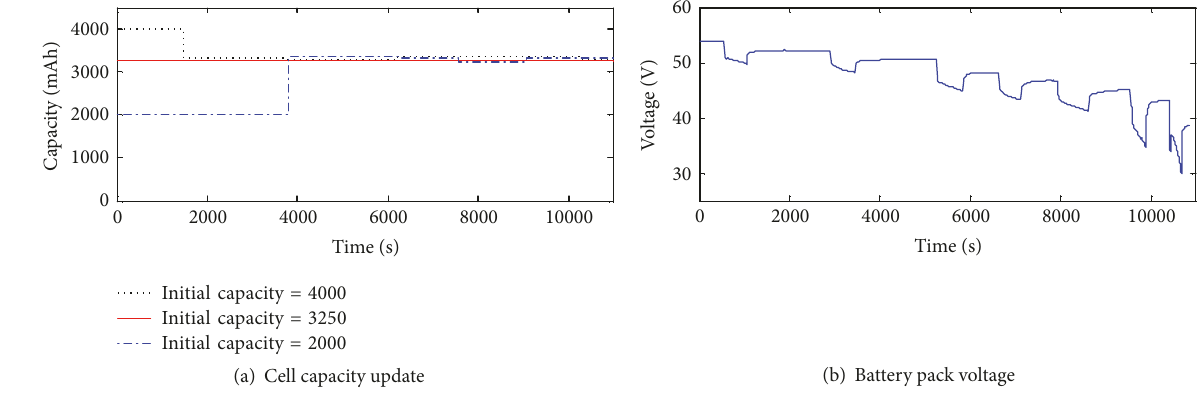
Figure 12: Automatic correction of the SOH.